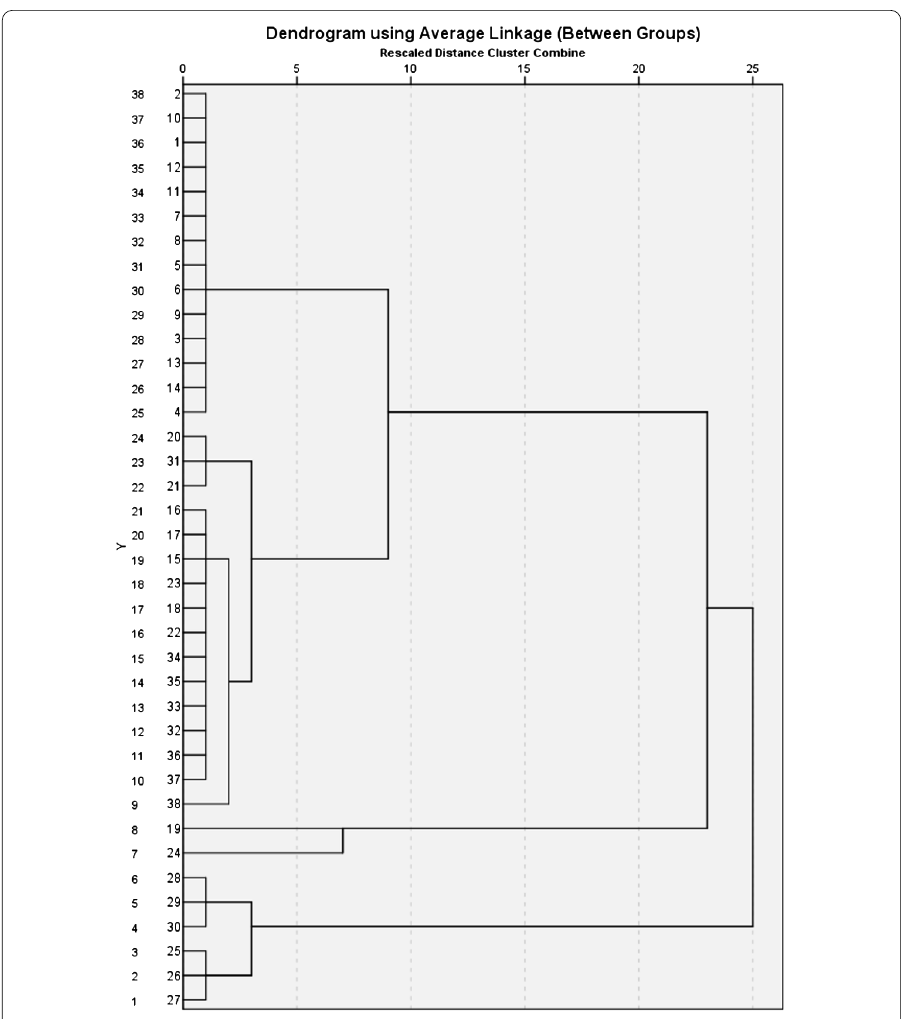
Figure 5 Hierarchical cluster analysis